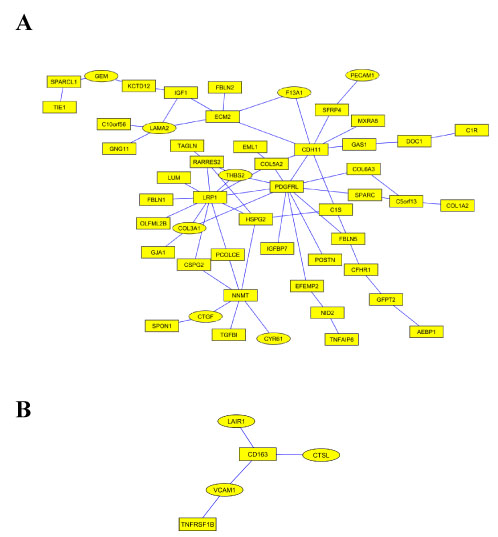
Coordinated breast tumor network modules (A) A breast tumor network module that involved in PDGF signalling. Genes in round shape have promoter regions that are predicted to be bound by transcription factor ZNF148.(B) A breast tumor network module related to inflammatory response, located in the same second-order cluster as the one in Figure 3a. Genes in round shape have promoter regions that are predicted to be bound by transcription factor POU2F1.